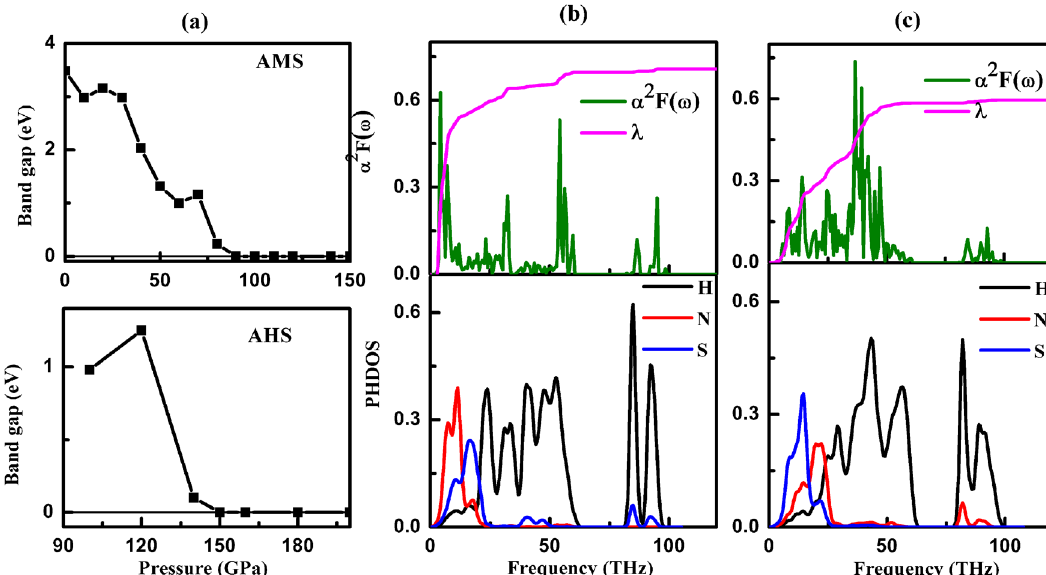
Fig. 7 Electronic properties of different mixtures. a Band gap evolution with pressure across best structures of AMS and AHS mixtures. b – c Eliashberg spectral function α 2 F( ω ), integrated electron – phonon coupling parameter λ and projected phonon densities of state (PHDOS) for b Abm2 -AMS at 100 GPa, c Cmma -AMS at 200 GPa.